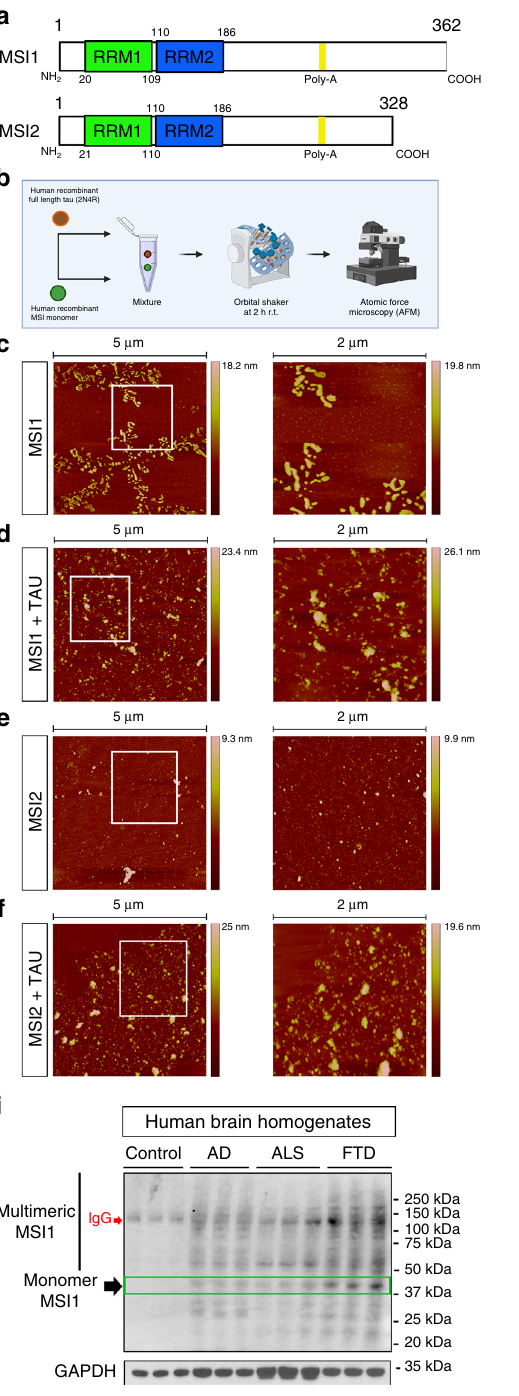
Fig. 1 MSI/tau aggregation in vitro and MSI proteins in AD, ALS, and FTD frontal cortex. a Schematic representation of MSI1 and MSI2 proteins (RRM; RNA Recognition Motif). b Diagram of experimental procedure to produce in vitro MSI and tau oligomers. c Representative 5 µ m and 2 µ m (white square in 5 µ m image) AFM fi elds of MSI1 oligomers. d Representative 5 µ m and 2 µ m (white square in 5 µ m image) AFM fi elds of MSI1/tau mixed oligomers. e Representative 5 µ m and 2 µ m (white square in 5 µ m image) AFM fi elds of MSI2 oligomers. f Representative 5 µ m and 2 µ m (white square in 5 µ m image) AFM fi elds of MSI2/tau mix oligomers. g Representative confocal images of Control, AD, ALS and FTD human brains. They were stained with TOMA-2 and MSI1 (showed in gray) and merge are presented in RGB (TOMA-2 red, MSI1/MSI2 green and DAPI blue; white scale bar: 20 µ m). h Representative confocal images of Control, AD, ALS, and FTD human brains. Tissues were stained with TOMA-2 and MSI2 (shown in gray) and the merged channel is presented (TOMA-2-red, MSI2-green, DAPI-blue; white scale bar: 20 µ m). i – j Western blot of MSI1 and MSI2 in control, AD, ALS, and FTD brain homogenates. GAPDH is also presented, and each sample is in triplicate (HMW: High Molecular